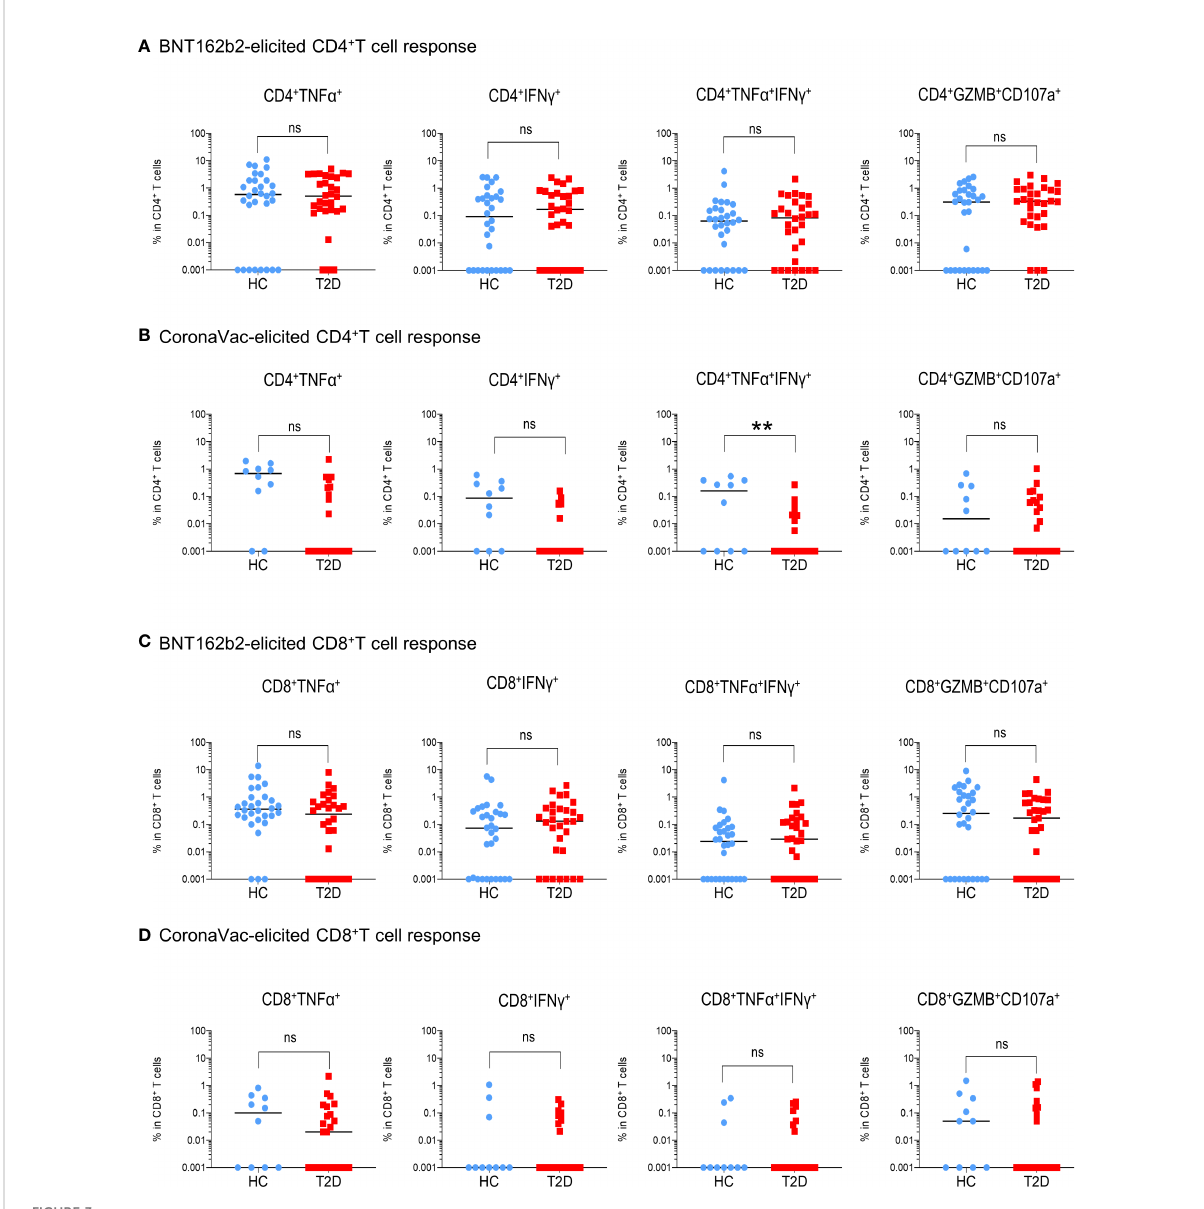
FIGURE 3 Extent of memory T cell responses 3-6 months following BNT162b2 and CoronaVac vaccination. PBMCs collected from BNT162b2 (n=30/ group) (A, C) and CoronaVac (n=10-25/group) (B, D) vaccinees were stimulated with S1 peptide pools. (A, D) Percentages of cytokine (TNF a + , IFN g + , TNF a + IFN g + and GZMB + CD107a + )-producing CD4 + (A, B) and CD8 + (C, D) T cells were determined by FACs analysis. Data shown are median and each symbol represents an individual. Statistical analysis were performed among the responders. ns: not signi fi cant ; **P<0.01.